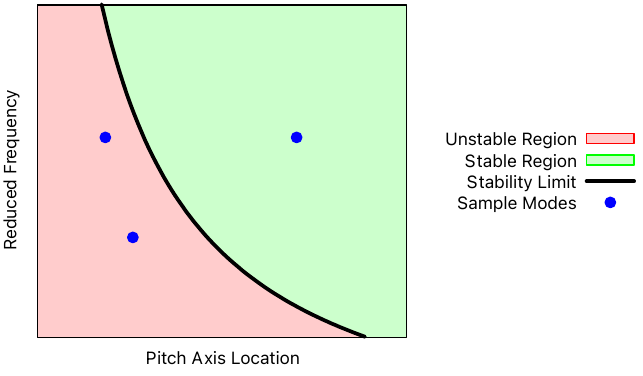
Figure 2. Sketch of stability map.